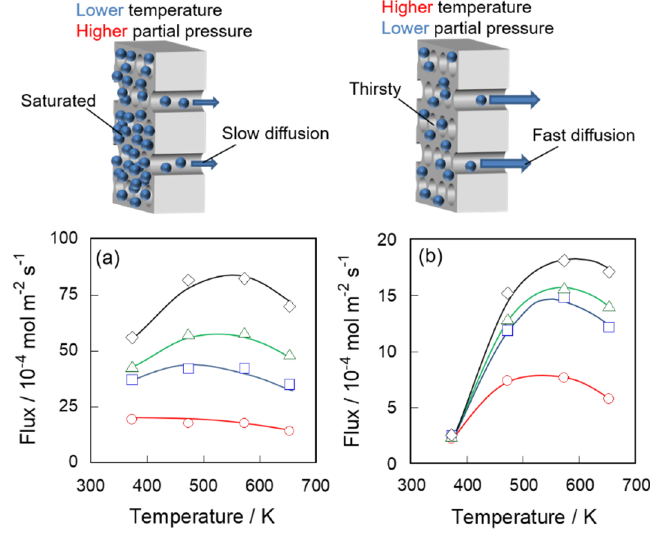
Figure 2. Membrane temperature dependency of n -hexane fluxes through ( a ) S-1 S and ( b ) S-1 M . Partial pressures of n -hexane are at ○, 10; □, 25; ▵ , 35 and ◊, 51 kPa.